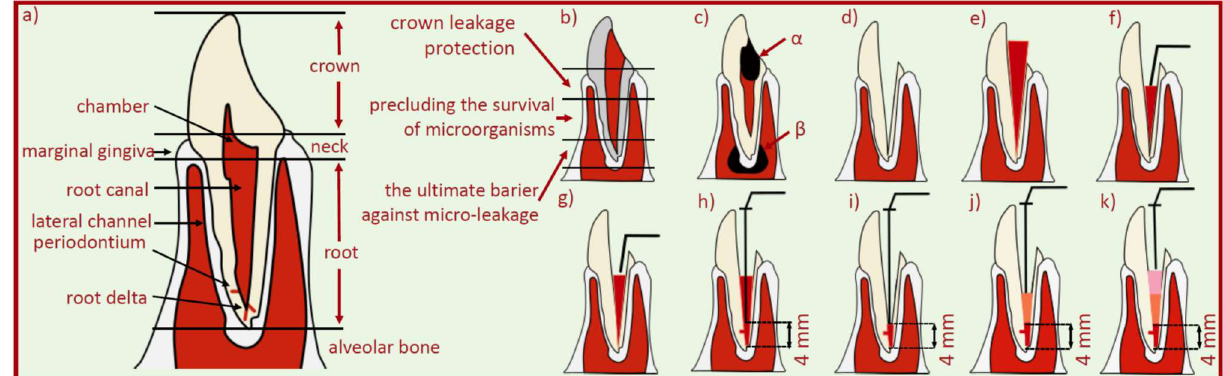
Figure 4. A diagram of a tooth cross-section showing: ( a ) the functions of the tooth pulp; ( b ) functions of filling the root canal; ( c ) dead pulp due to a carious lesion (α) with a periapical lesion (β); ( d ) evacuation of the ventricular-root pulp and conical preparation of the root canal; ( e ) fitting the main cone to the root canal; ( f ) cutting off the main stud with a heated plugger; ( g ) condensation at the mouth of the severed main cone with a cold Buchanan plugger; ( h ) plasticizing the main stud by introducing the heated plugger to a depth 4 mm less than the working length and cutting off the excess stud; ( i ) condensation of the plasticized main cone with a cold Buchanan plugger; ( j ) filling 1/3 of the central part of the canal with liquid gutta-percha plasticized outside the canal and then condensing the material with a cold Buchanan plugger as in ( i ); ( k ) final filling of the canal with liquid gutta-percha plasticized outside the canal and then condensation of the material with a cold Buchanan plugger as in point ( i ).